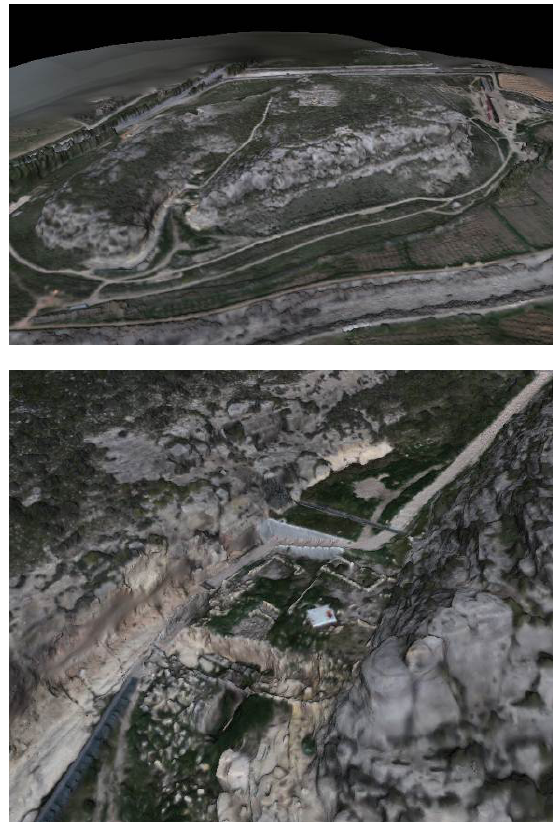
Figure 7. Multi-resolution 3D model of the archaeological settlement (up). Detailed 3D model of the “Reguerón” (down). By this multi-resolution approach, the final inspection of the archaeological site could be adapted to any area, as is showed in the interest area of “El Reguerón”, where the subcentimeter resolution achieved for the walls and construction (Figure 8 down) was integrated with the rest of the archaeological site (Figure 8 top). This multi-resolution capability opens a range of possibilities for a spatial analysis, settlement interpretation, patterns recognition, and the establishing relationships among the elements (sites, artefacts locations,